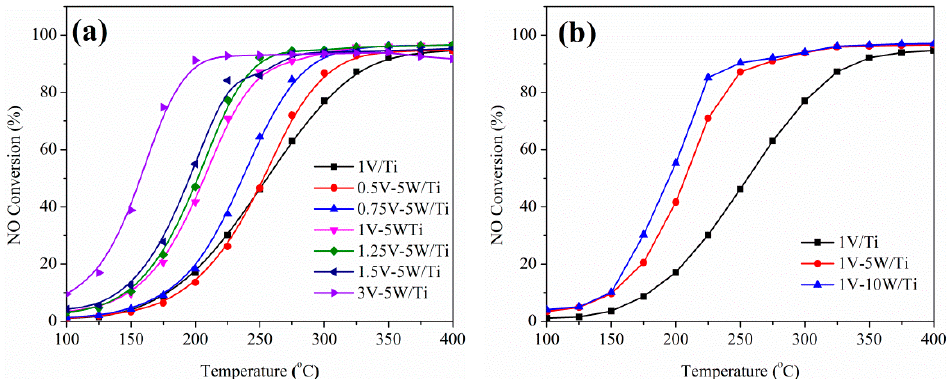
Figure 1. NO x conversion versus temperature over different catalysts: ( a ) ( x )V-5W/Ti with different V 2 O 5 loadings; ( b ) 1V-( y )W/Ti with different WO 3 loadings. Reaction conditions: [NH 3 ] = [NO] = 400 ppm, [O 2 ] = 0.5%, balance N 2 , gas hourly space velocity (GHSV) = 30,000 h − 1 .